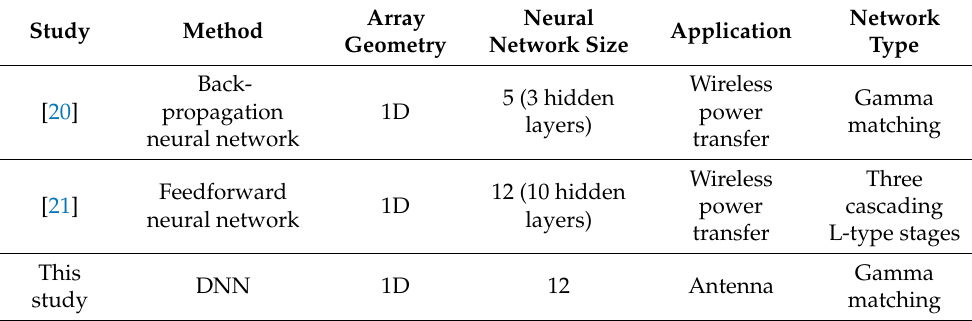
Table 5. Comparison of machine learning methods for impedance